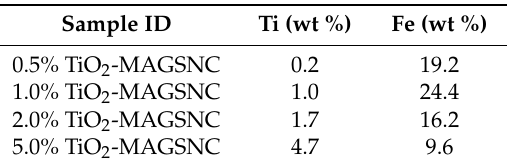
Table 2. Ti and Fe content on TiO 2 -MAGSNC photocatalysts (obtained from energy-dispersive X-ray spectroscopy (EDX) analysis).